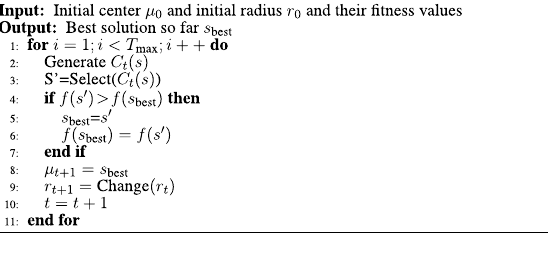
Algorithm 1: Description of the VS algorithm Özkış and Babalık